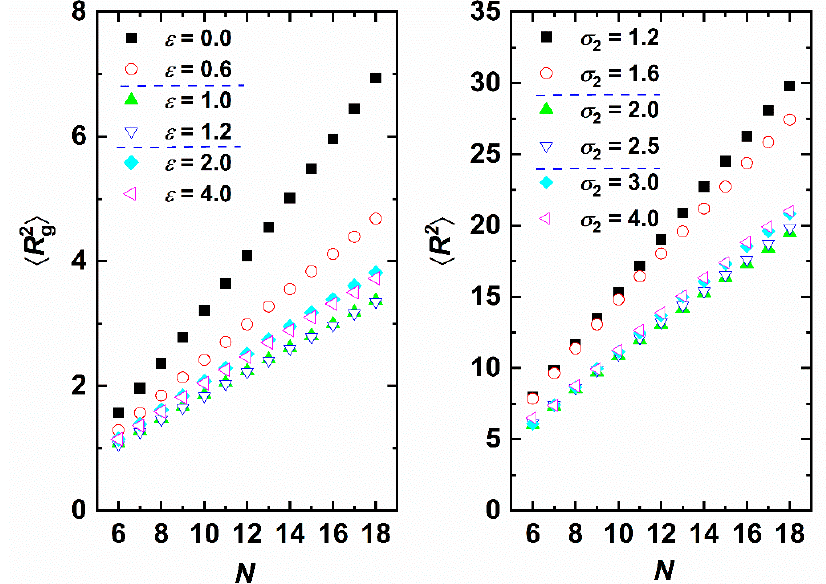
Figure 11. E ff ect of chain length, N , on chain size. Left panel: Mean square radius of gyration, (cid:104) R 2 g (cid:105) , for various attraction intensities, ε , with fixed range σ 2 = 1.2. Right panel: Mean square end-to-end distance, (cid:104) R 2 (cid:105) , for various attraction ranges, σ 2 , with fixed intensity ε = 0.5. Dashed horizontal blue lines in legend identify transitions to di ff erent phase regimes: amorphous → crystalline → glassy.